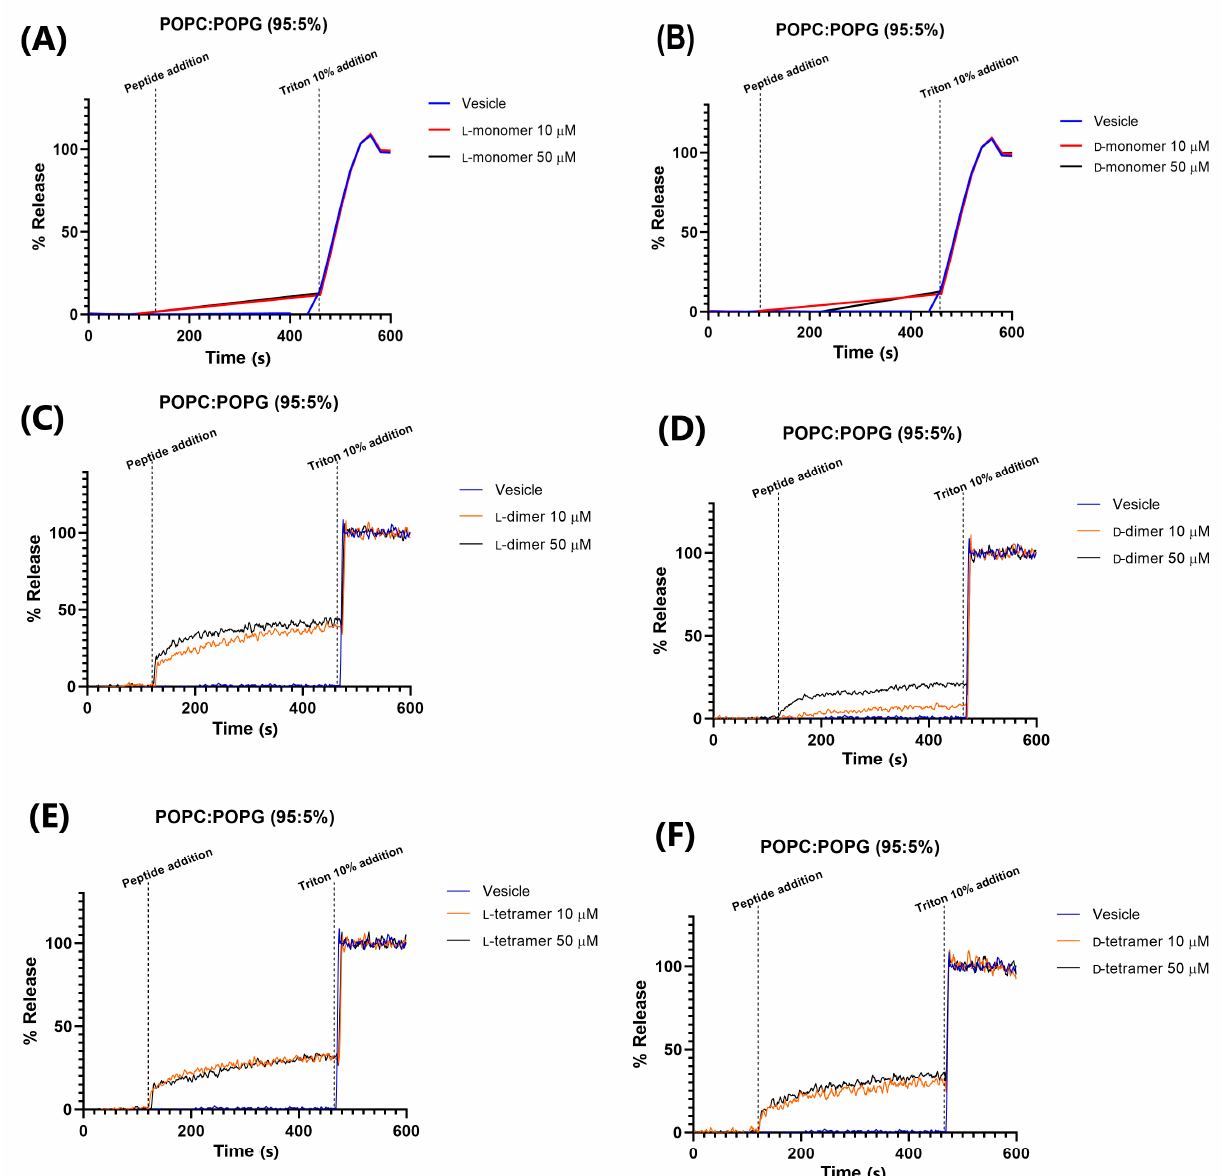
Figure 7. Permeabilization in 95% POPC and 5% POPG vesicles of the peptides: ( A ) L-monomer, ( B ) D-monomer, ( C ) L-dimer, ( D ) D-dimer, ( E ) L-tetramer, and ( F ) D-tetramer at concentrations of 10 and 50 μ M.